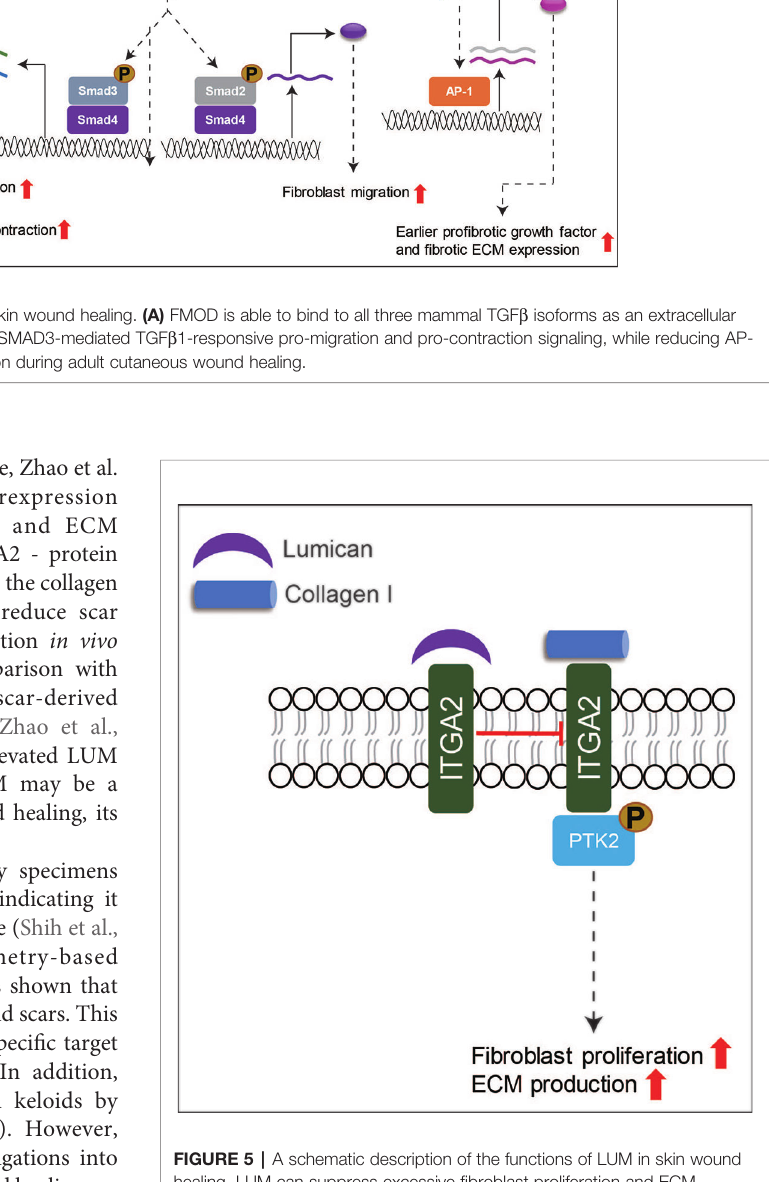
FIGURE 5 | A schematic description of the functions of LUM in skin wound healing. LUM can suppress excessive fi broblast proliferation and ECM production via inhibiting ITGA-PTK2 signaling through binding to